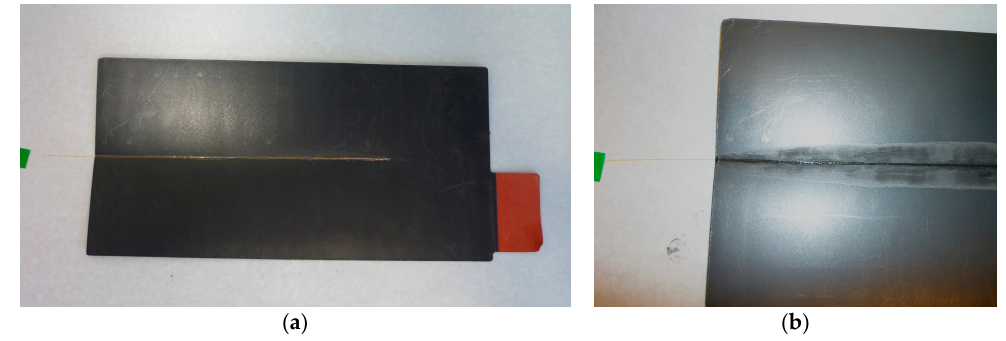
Figure 2. Graphite active material-coated anode current collector: ( a ) In the area of the recognizable glass fiber, the active material is removed from the electrode and the optical waveguide is inserted into the resulting cavity; ( b ) the fiber is coated with active material, which closes flat against the surface after drying.